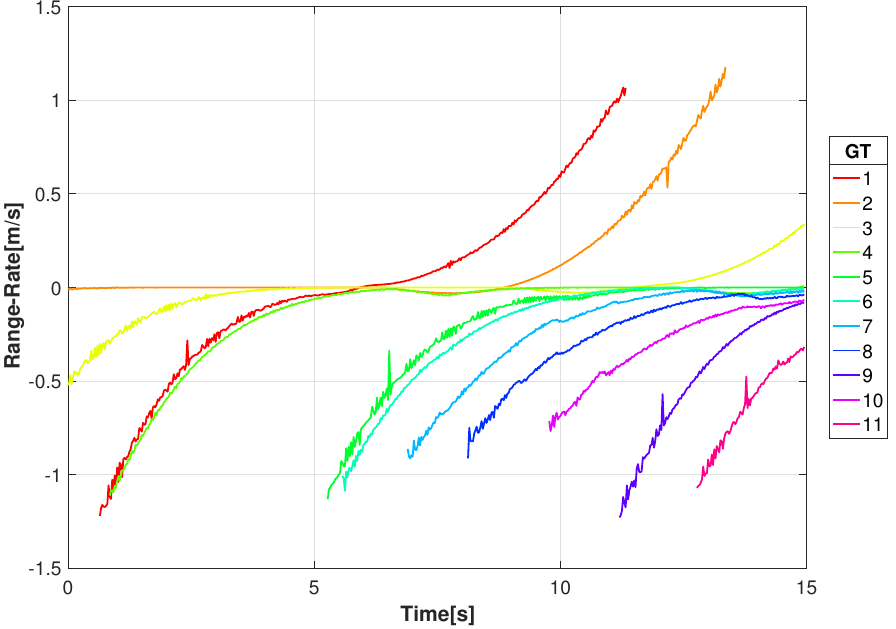
Figure 6. Range-rate of the moving ground targets from the video sensor for the given video